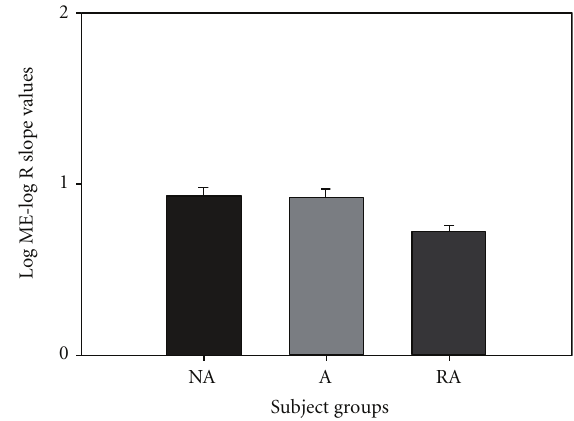
Figure 1: Resistive load magnitude estimation was significantly lower ( P < 0 . 05) for LTA subjects than for both NA and A groups. There was no significant di ff erence between the NA and A groups.